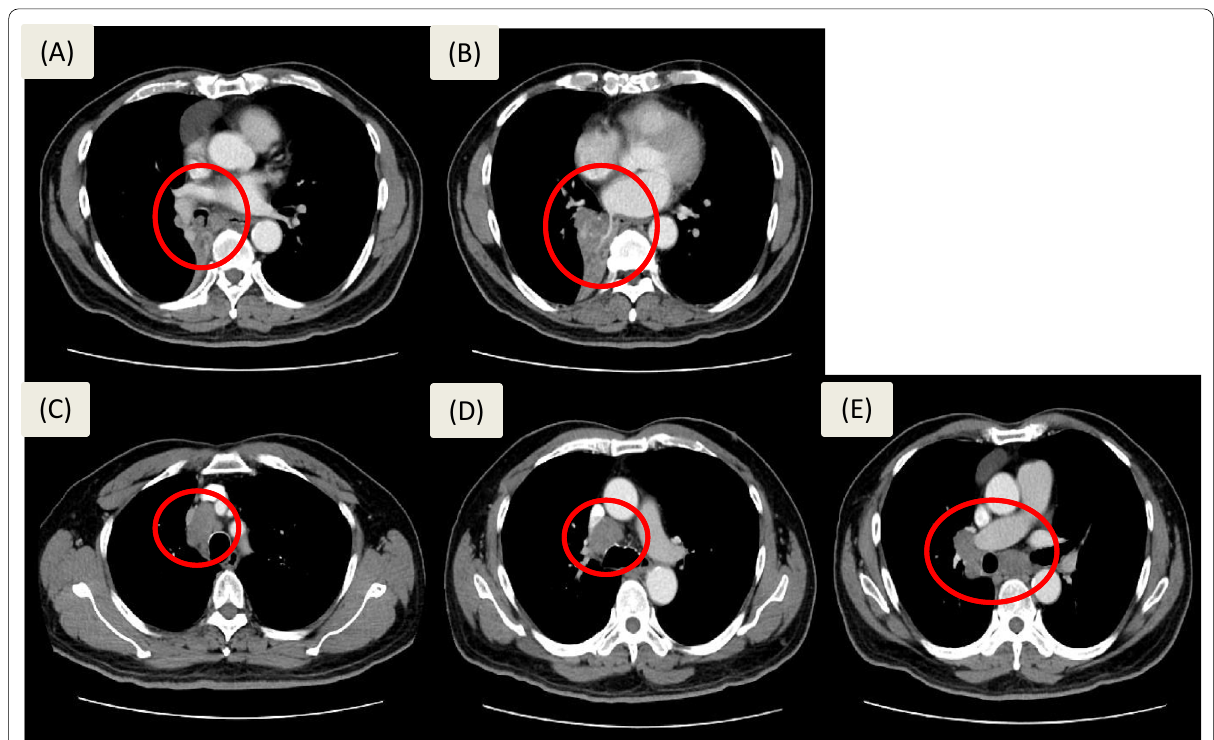
Fig. 1 Series of chest CT scan images before treatment showing RLL lung tumor, cT4N2M0, stage IIIB, invading into the RIMB and right inferior pulmonary vein ( a , b ). Enlarged lymph nodes were noted at right para‑tracheal, pre‑carina, right hilar and sub‑carina regions, compatible with metastatic lymphadenopathy ( c , d , e ). A cystic anterior mediastinal lesion was also